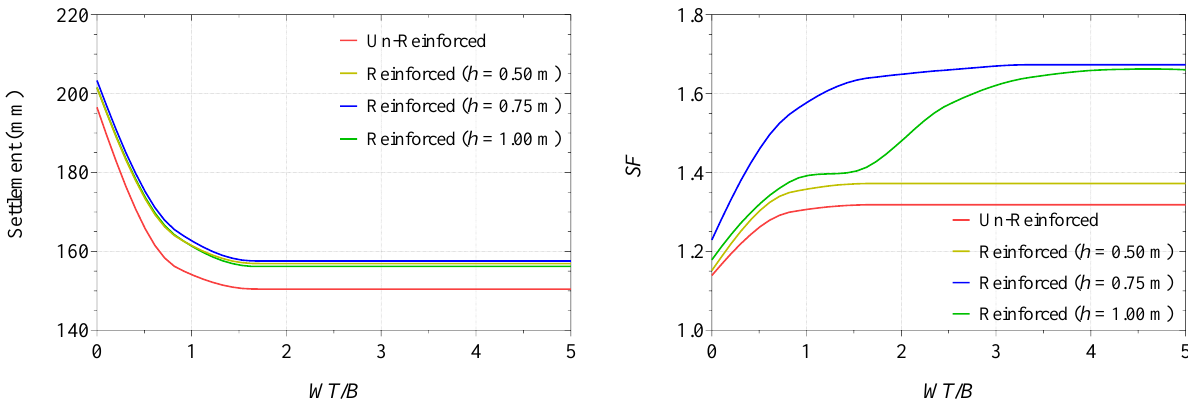
Figure 5. The settlement and the safety factors of the soil-footing system due to the changes of WT/B and h (for all tests: u=0.5 m, b=12 m, n=3, and St=50